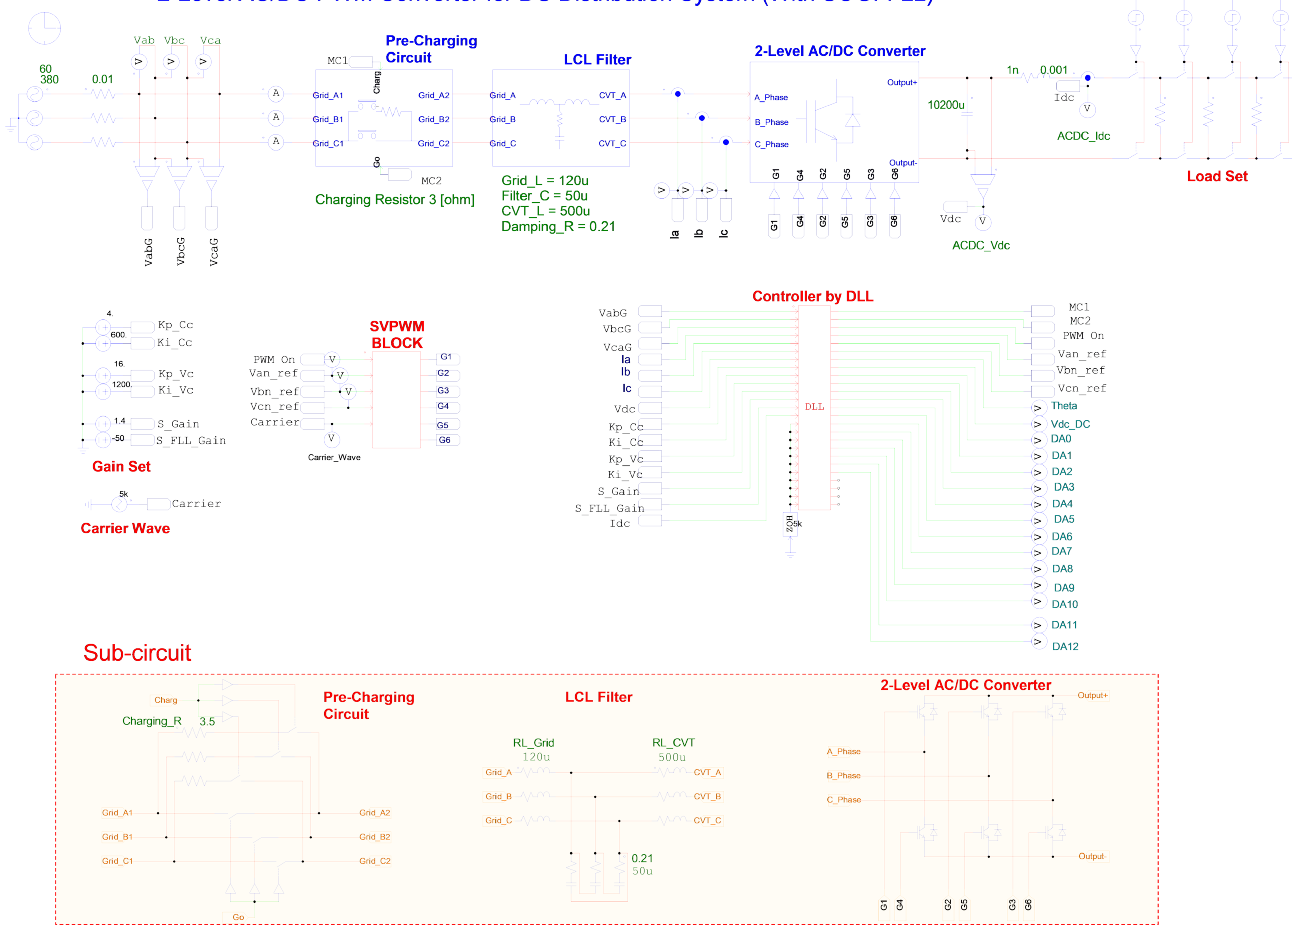
Figure 15. 3-phase AD/DC PWM converter schematic of DC distribution system used in